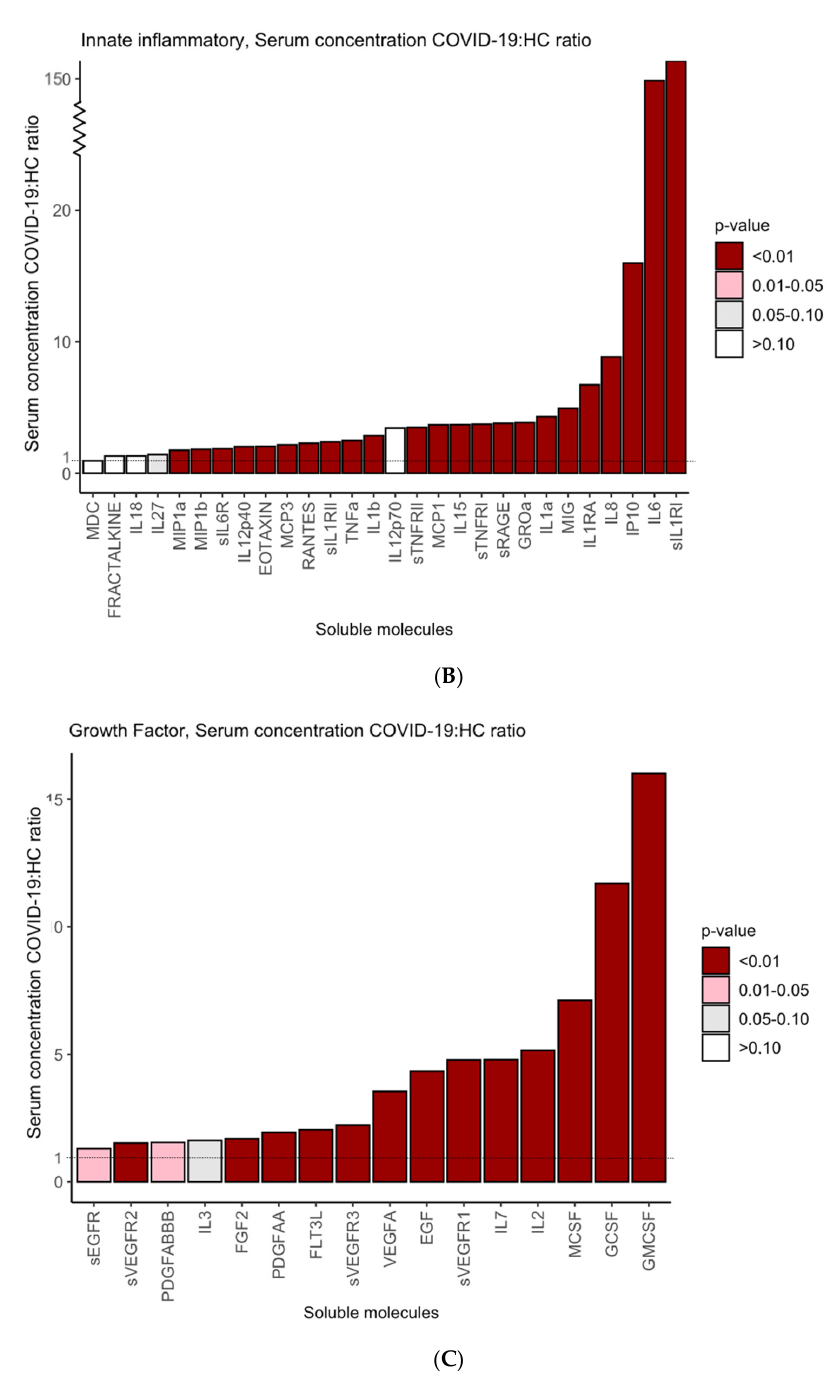
Figure 1. Serum levels of cytokines and growth factors in COVID-19 patients and HC. Y axes indicate the ratios of concentrations of each cytokine in the COVID-19 patients to those in HC. Ratios for adaptive IR-related cytokines ( A ), innate inflammatory-related IR cytokines ( B ) and growth factors ( C ). The vertical bars represent the mean of the COVID-19:HC ratios for the indicated molecule. The intensity of color denotes significant differences between serum levels of each cytokine in the COVID-19 patients and HC.